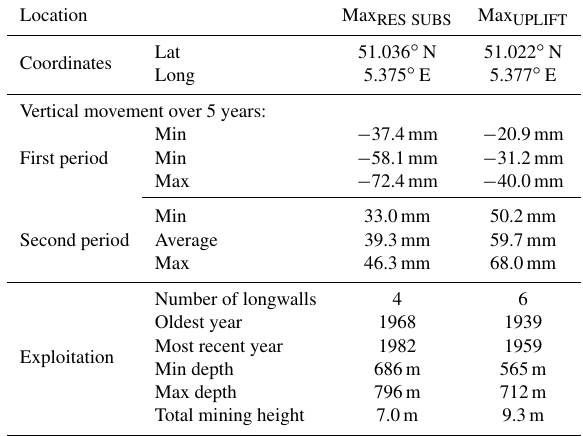
Table 3. Information on the two locations, corresponding to the zones with approximately largest residual subsidence in the first pe- riod (Max RES SUBS ) and largest uplift in the second observation period (Max UPLIFT ): information on total movement of 10 reflec- tors around coordinates given in 5-year time zones studied and data on exploitation below these